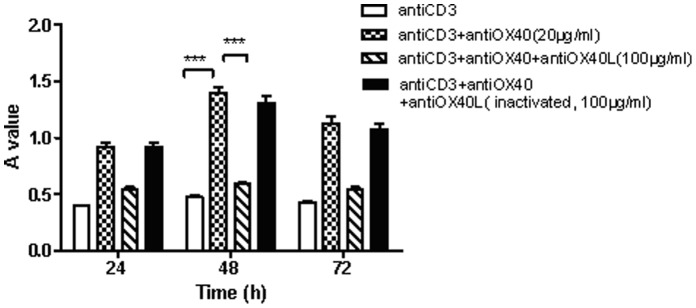
The proliferation of lymphocytes after interfered OX40-OX40L interaction.***p<0.001 compared to control.